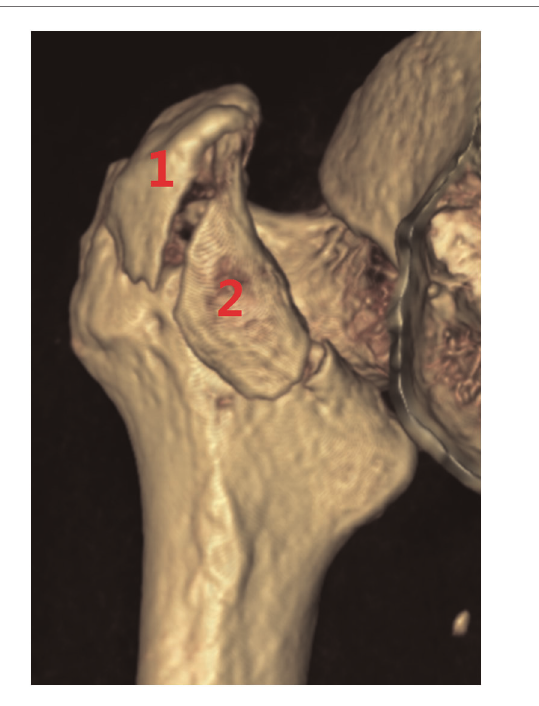
FIGURE 6 Subtype A1.4, pertrochanteric fracture with posterior greater trochanter and intertrochanteric crest fragments. These upper posterior coronal structures do not interfere with the stability between head – neck and shaft. 1 posterior greater trochanteric fragment, 2 intertrochanteric